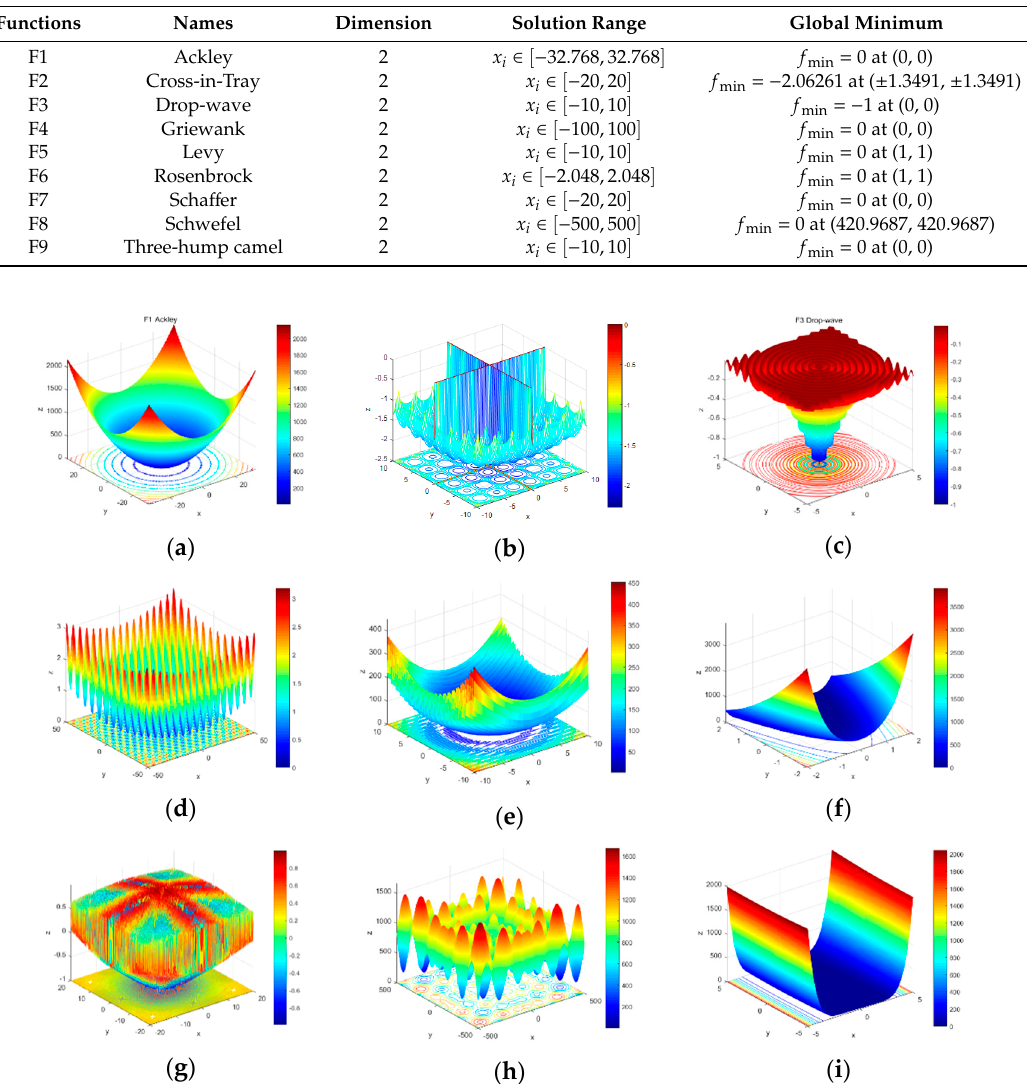
Figure A1. A two-dimensional perspective with contours of the benchmark test functions, including ( a ) Ackley function (F1), ( b ) Cross-in-Tray function (F2), ( c ) Drop-wave function (F3), ( d ) Griewank function (F4), ( e ) Levy function (F5), ( f ) Rosenbrock function (F6), ( g ) Schaffer function (F7), ( h )